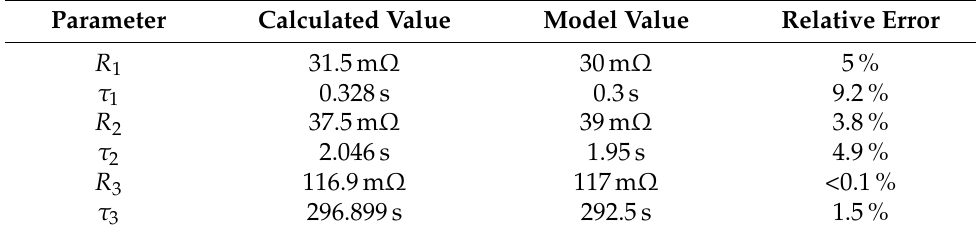
Table 1. Comparison of the parameter set of the battery model and the values derived by the